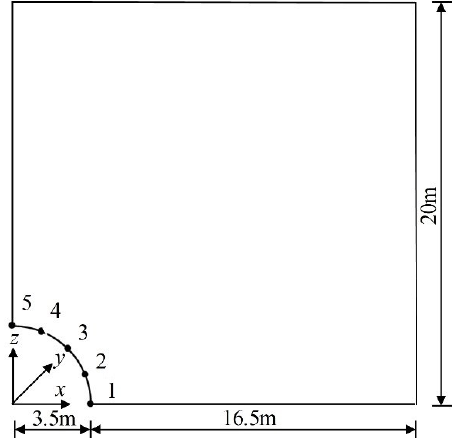
Table 3. The measured displacements of points.